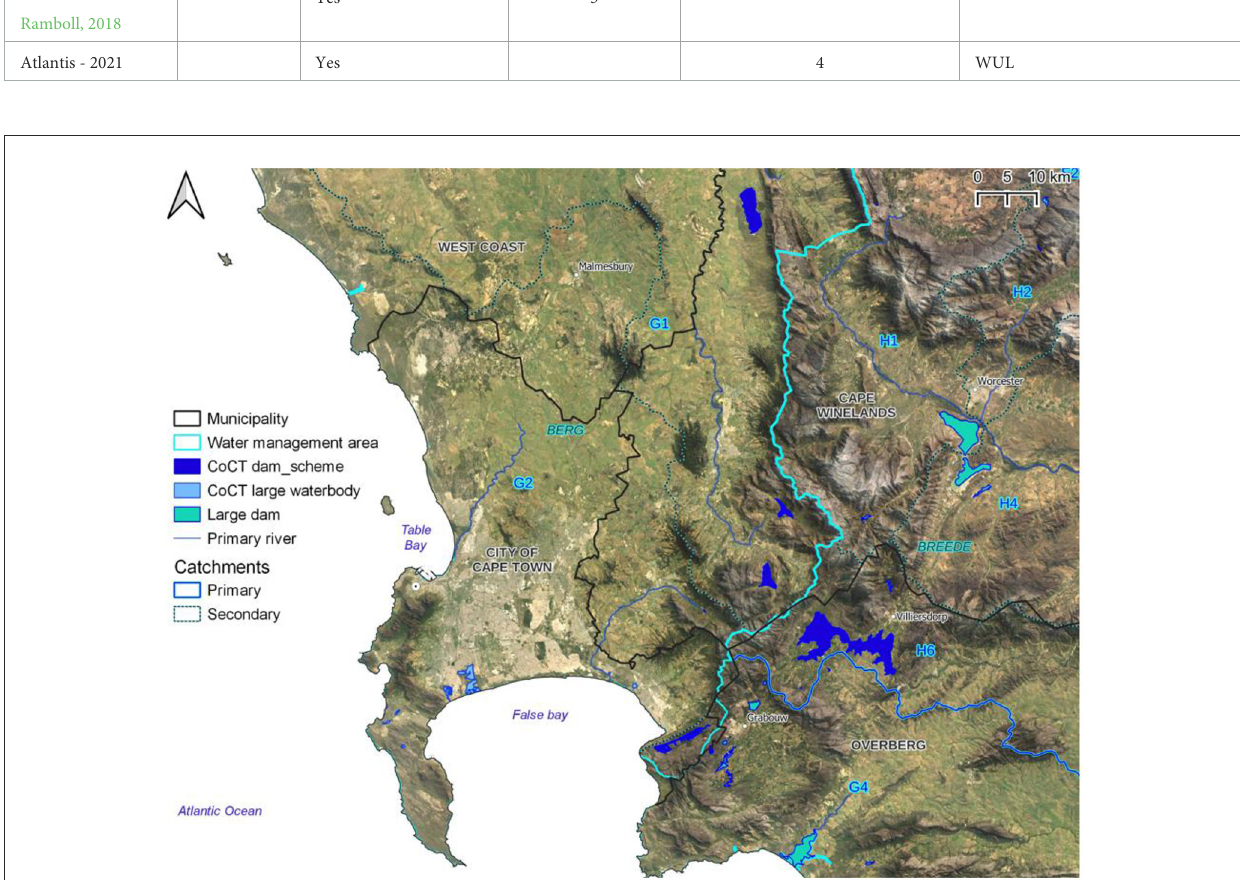
FIGURE1 Map showing overlaps between water management areas, CMA areas and groundwater resources (specific to Cape Town’s water supply); Source: Flugel (2021) from Faragher (2022). Cape Town is located within the Berg Catchment.